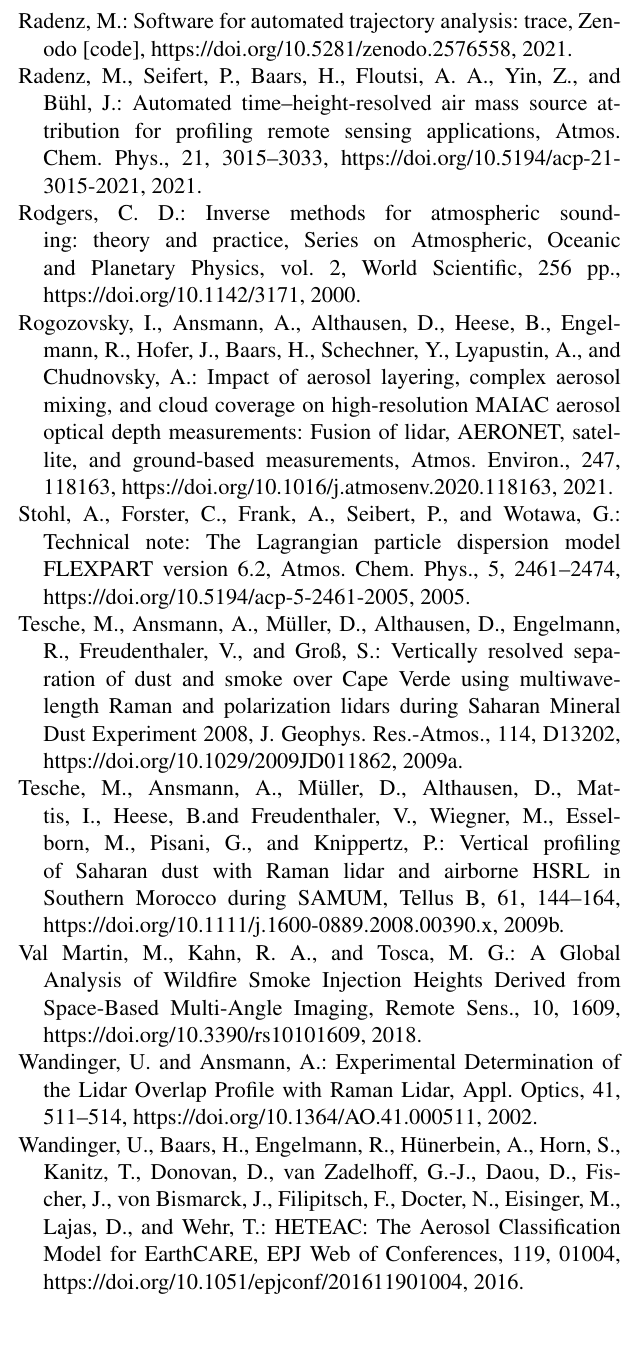
PollyNET: Worldwide observations with the portable Raman lidar systems (Polly), PollyNET [data set], https://polly.tropos.de/, last access: 24 January